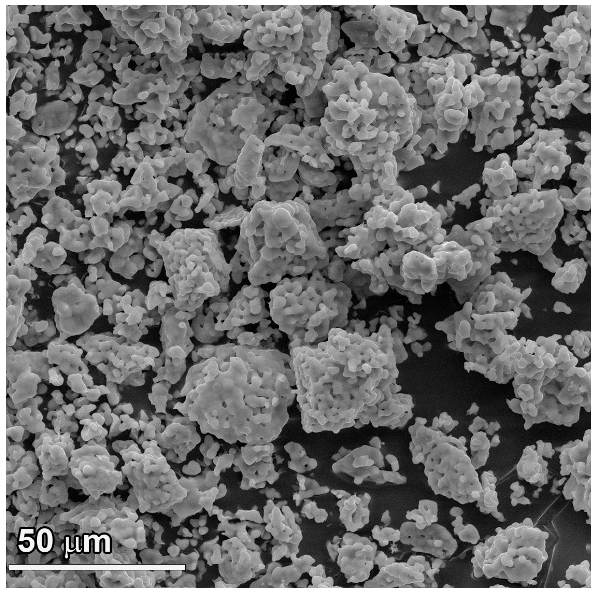
Figure 1. SEM image of Ca 8 MnEu(PO 4 ) 7 .